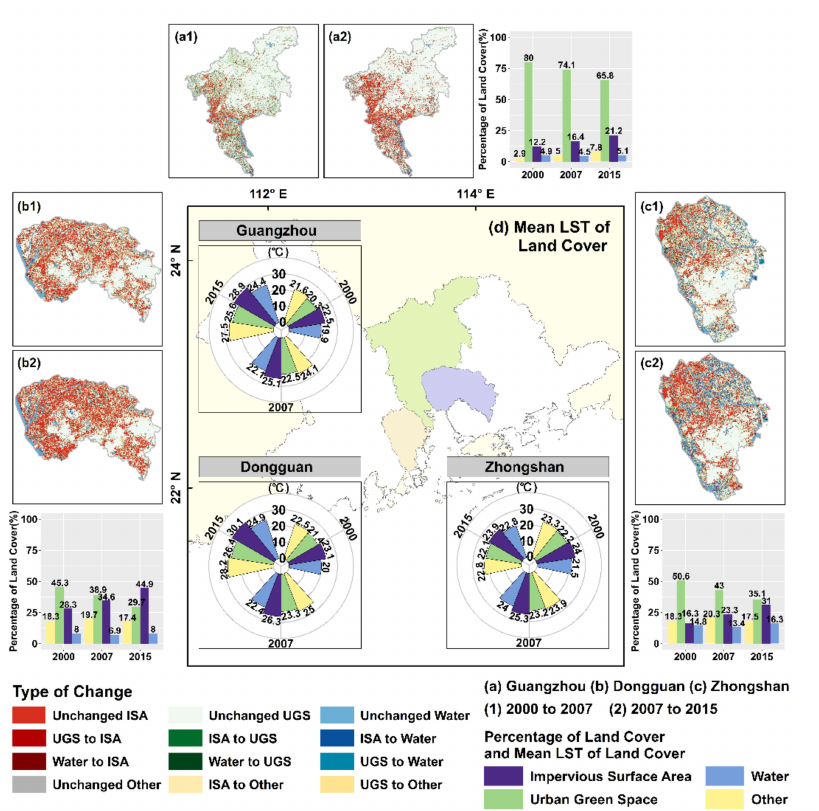
Figure 6. Changes of LSC within Guangzhou, Dongguan and Zhongshan from 2000 to 2015, percent- age of different LSC and the LST related to each